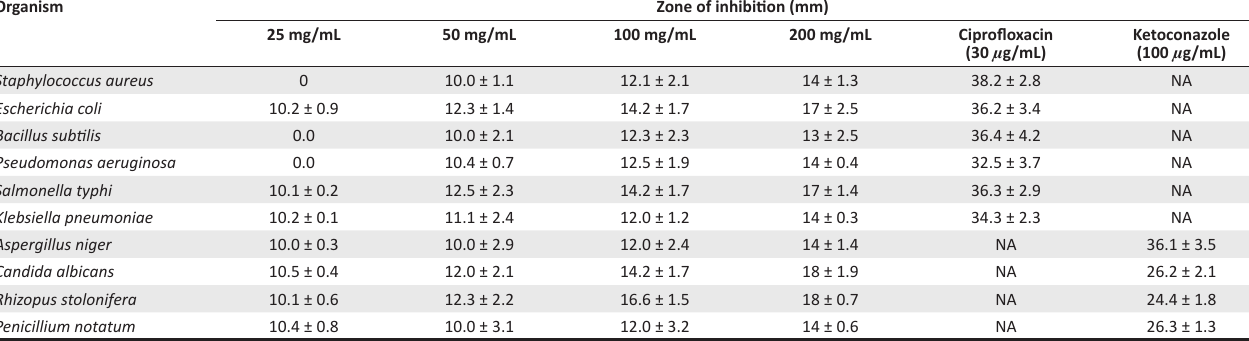
TABLE 1: Antimicrobial effect of the ethanol leaf extract of Ficus exasperata.